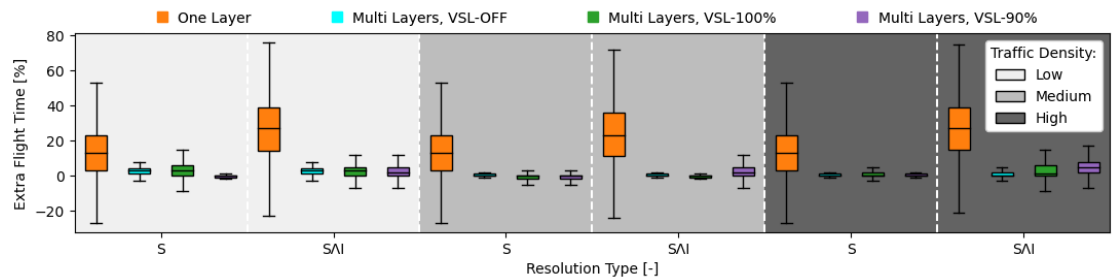
Figure 27. Extra flight time per